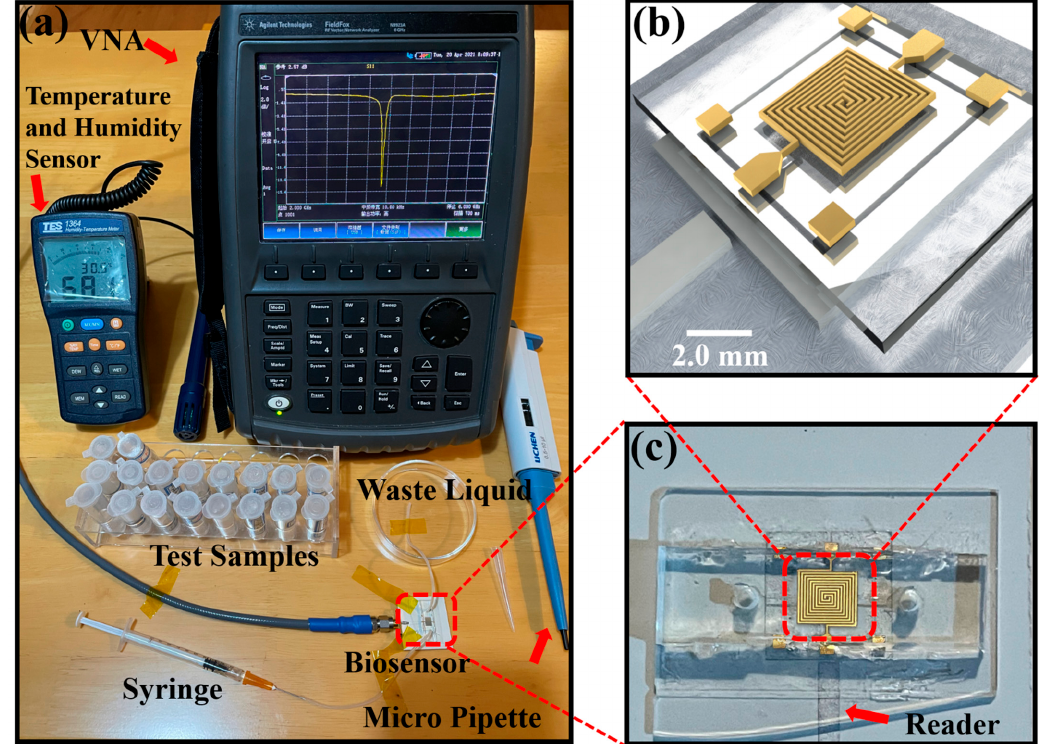
Figure 4. ( a ) Proposed experimental setup for chip measurement of detecting variable glucose level. ( b ) The 3D schematic diagram of RFID chip. ( c ) The fabricated biosensor.